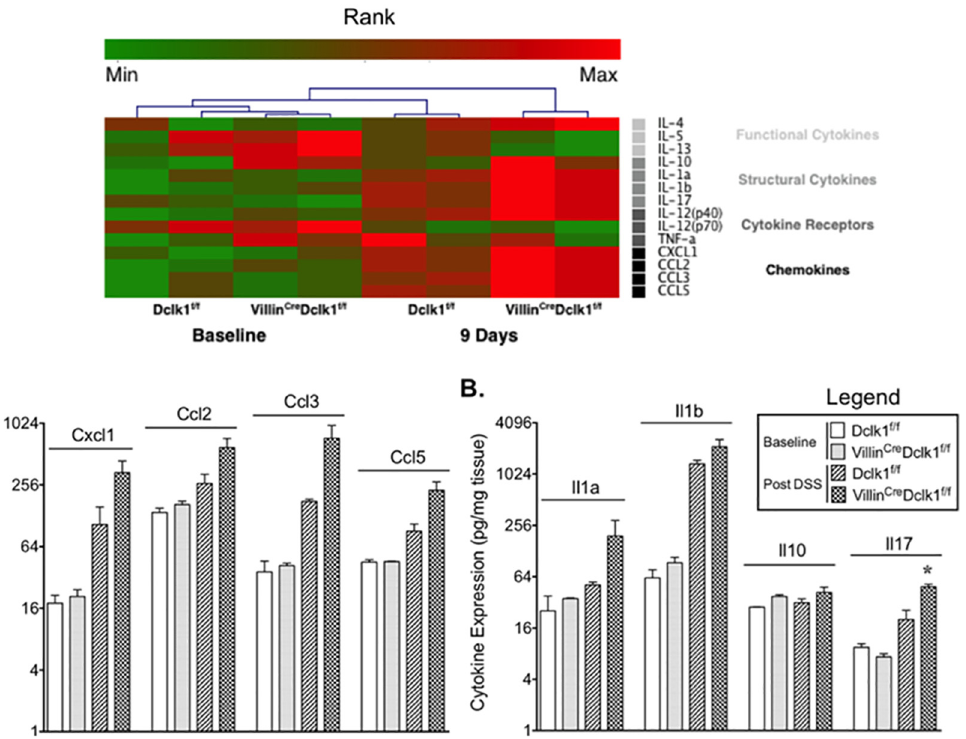
Fig 6. Epithelial deletion of Dclk1 upregulates pro-inflammatory cytokines and chemokines after DSS treatment. A. Heatmap of Bio-Plex Pro Mouse Cytokine 23-Plex Assay results. B . The individual expression levels of structural cytokines, IL-1 α , IL-1 β , IL-10, and IL17. C . The individual expression levels of chemokines, Cxcl1, Ccl2, Ccl3, and